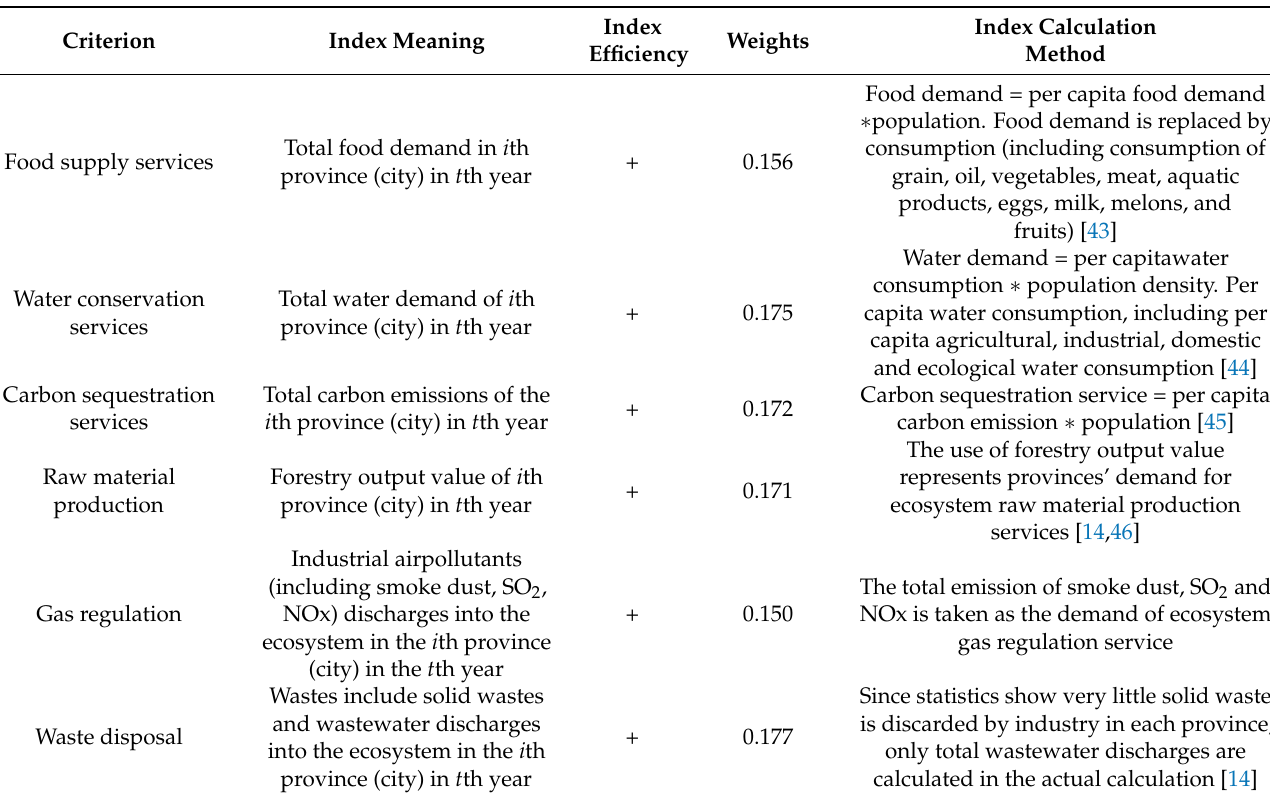
Table 2. Index system of provincial ecosystem service demand evaluation in